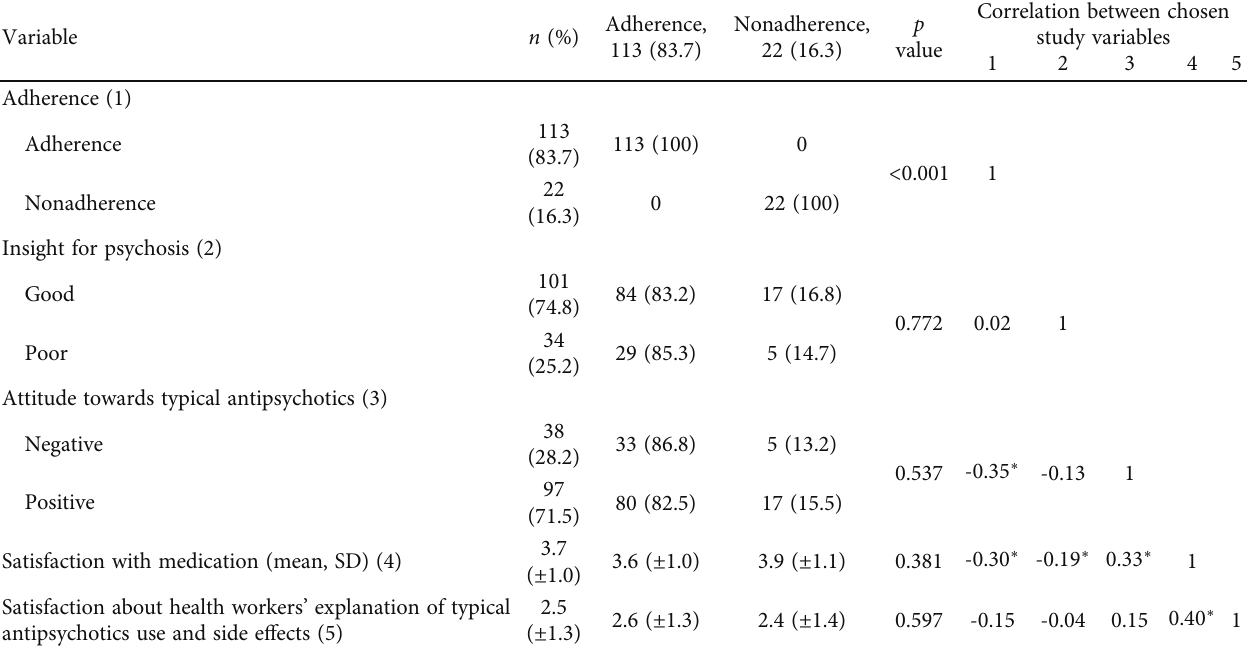
Table 2: Level of adherence to antipsychotic medications among schizophrenia